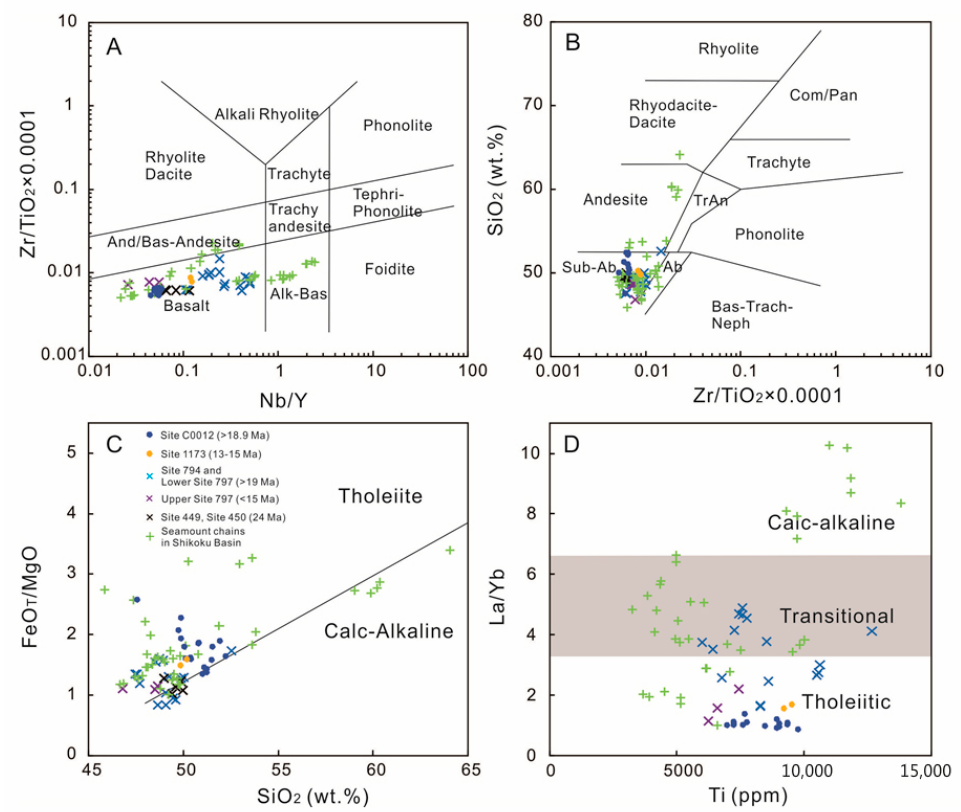
Figure 6. Classification diagrams for Cenozoic volcanic rocks from the Shikoku Basin: ( A ) Nb/Y versus Zr/TiO 2 × 0.0001; ( B ) Zr/TiO 2 × 0.0001 versus SiO 2 (wt.%); ( C ) SiO 2 (wt.%) versus FeO T /MgO; ( D ) Ti (ppm) versus La/Yb. Filled symbols represent new original data. Cross symbols represent referenced data. The Site 797, 794 data in the Japan Sea are from Reference [27], the Site 449, 450 data in the Parece Vela Basin are from Reference [28], and the seamount chains in Shikoku Basin are from Reference